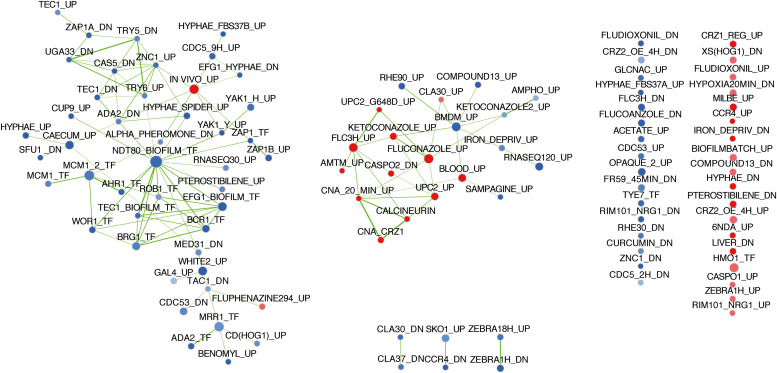
GSEA enrichment map of FLC regulated genes in clinical isolate DSY4452. Analysis parameters were as follows: norm, meandiv; scoring_scheme, weighted; set_min, 15; nperm, 1000; set_max, 500. GSEA results were uploaded into Cytoscape 3.0 with the following parameters: P-value cutoff, 0.01; FDR q-value, 0.05. Red nodes represent enriched gene lists in upregulated genes from the GSEA. Blue nodes represent enriched gene lists in downregulated genes from the GSEA. Nodes are connected by edges when overlaps exist between nodes. The size of nodes reflects the total number of genes that are connected by edges to neighboring nodes. Edge thickness reflects the level of confidence between nodes.